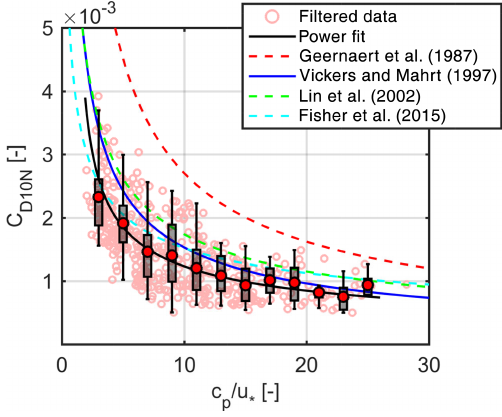
Figure 4. Drag coefficient as a function of wave